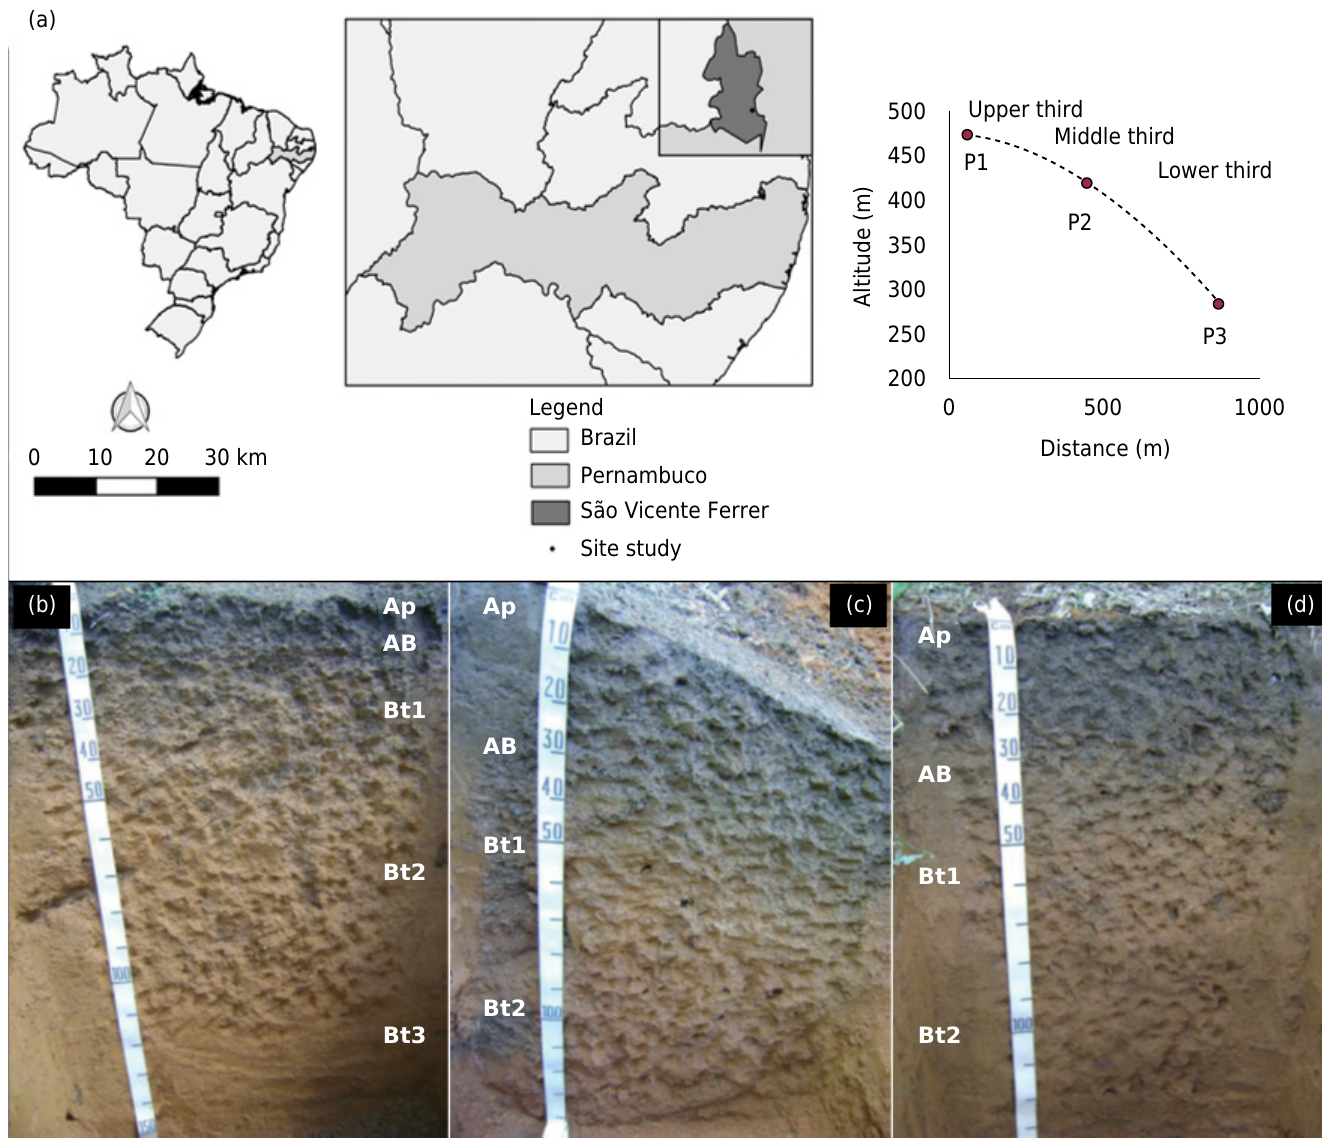
Figure 1. Location of the study area, with the relief positions, altitudes, and distance between the profiles in the municipality of São Vicente Férrer, Pernambuco, Brazil (a). Image of the profiles: Profile 1 (b): Argissolo Vermelho-Amarelo Distrófico nitossólico (Nitic Acrisol); Profile 2 (c): Argissolo Vermelho-Amarelo Distrófico típico (Haplic Acrisol); Profile 3 (d): Argissolo Vermelho-Amarelo Eutrófico nitossólico (Nitic